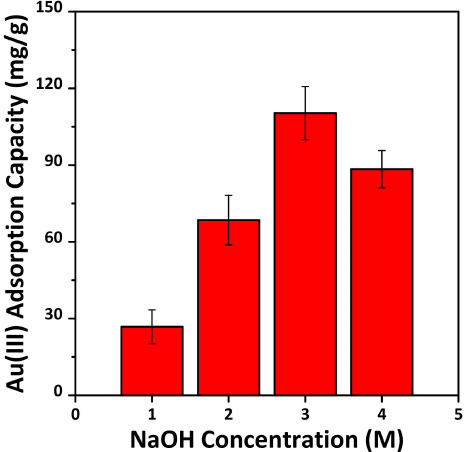
Figure 7. Maximum Au(III) adsorption capacity of the thiol-functionalized samples, MS-M1-SH, MS-M2-SH, MS-M3-SH and MS-M4-SH: pH 2.0, V/m = 1.0 L/g, [Au(III)] = 300 mg/L and 25 ◦ C for 24 h. Error bars denote standard